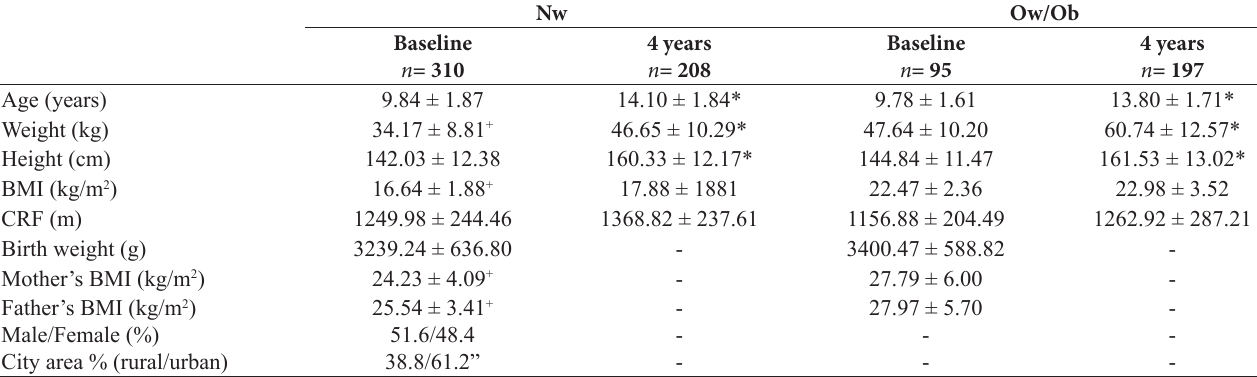
Table 1. Data of normal weight and overweight/obese youth at baseline and at 4-year follow-